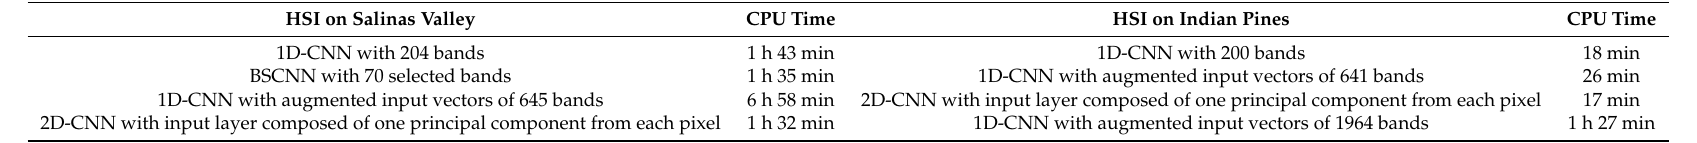
Table 5. Computational time for training and testing